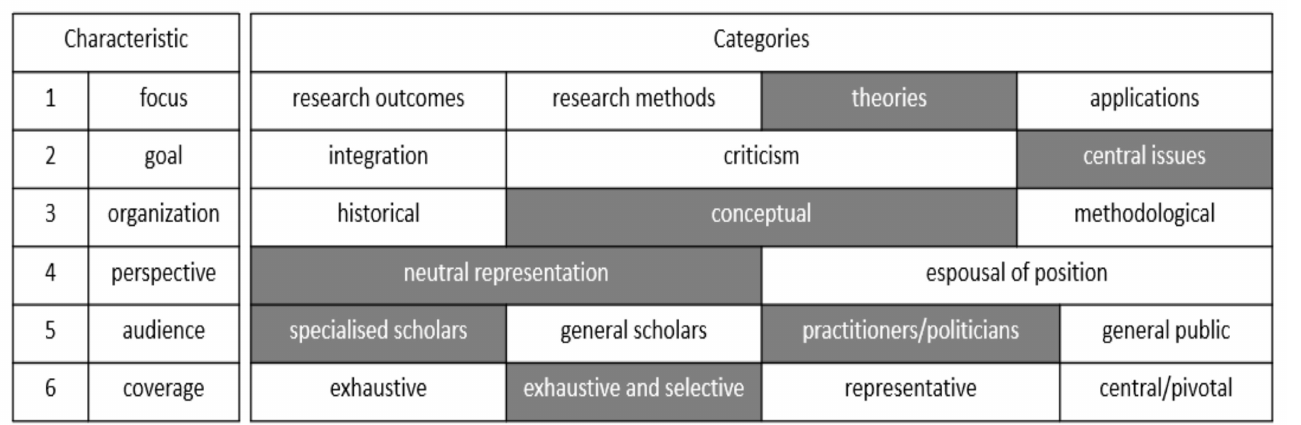
Figure 6. Our literature review taxonomy, as proposed by Randolph